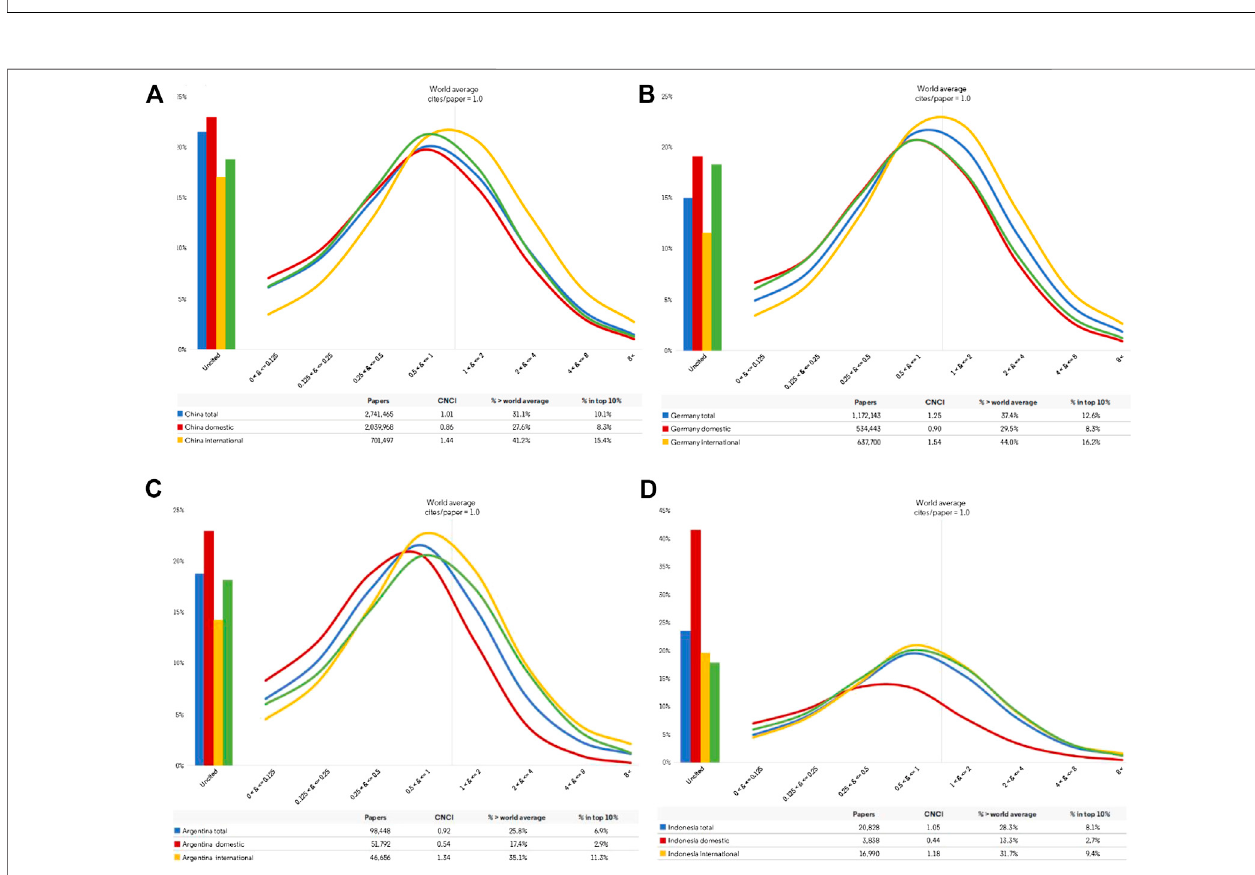
Figure4|(A) – (D) ImpactPro fi lesforfourG20countriesforarticlesandreviewsindexedonthe WebofScience duringtheten-yearperiod2009 – 2018.Eachpro fi le includes three extracts for the country plus a reference benchmark taken from the complete G20 dataset. The three extracts for each country are the Impact Pro fi le curvesfor:totalnationaloutput;domesticoutput(withnointernationalco-author);andinternationallycollaborativeoutput.Eachcurveshowsuncitedpapers(histograms to the left) and the distribution of output across eight categories of increasing impact relative to world average. The green line is a common reference set for all the graphs and marks the average for the complete G20 dataset. (A) China (B) Germany. (C) Argentina (D) Indonesia.